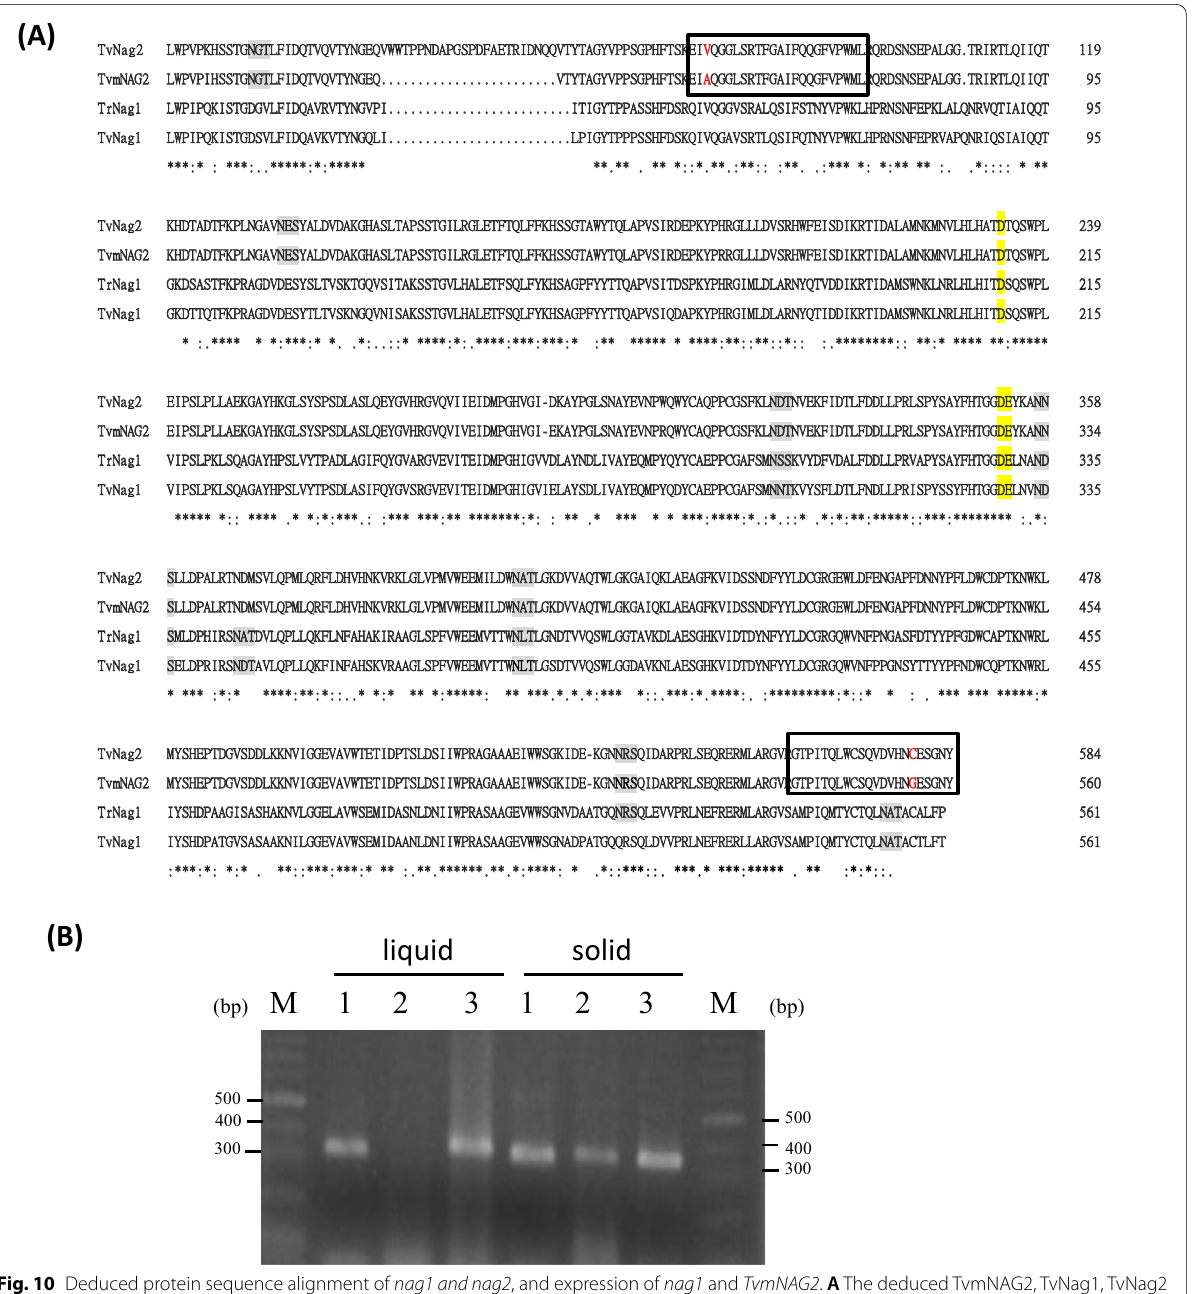
According to the genome-wide analyses, two putative genes, nag1 and nag2 of GH20 family encoding NAGase , are in the genome of T. virens , T. atroviride or T. reesei